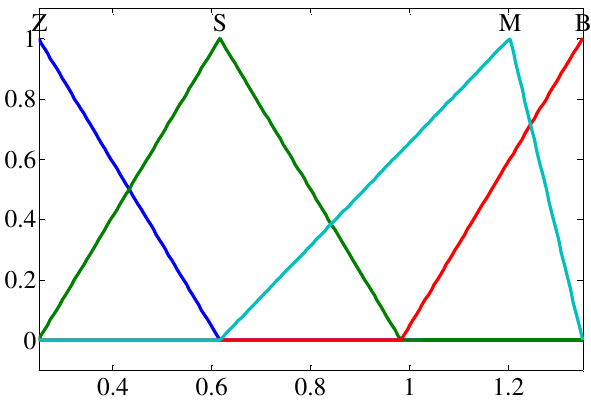
Figure 7. Membership function of expansion factor α1, α2.